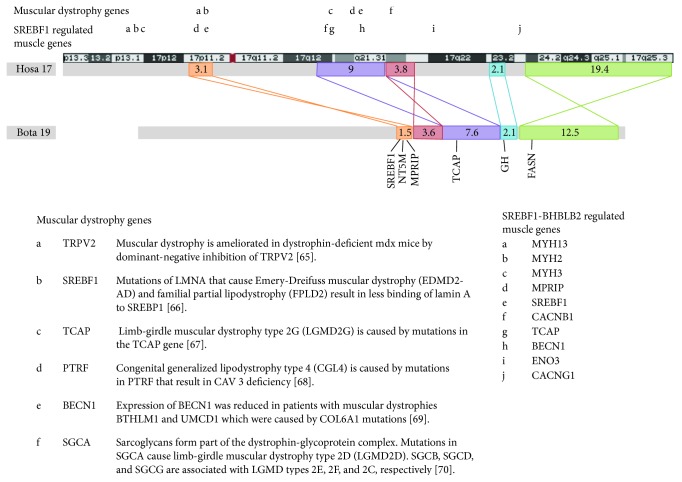
Marbling and muscular dystrophy are syntenic on Bota 19 and chromosome 17. Coloured boxes represent segments with the same gene content. Crossed joining lines indicate inverted translocations. Numbers represent Mb. Synteny was determined by the positions of homologous genes in the human assembly Hg 38 and bovine assembly BosTau8 located using the UCSC Genome Browser. Inverted sections and the exact location of boundaries between blocks were determined by dotplots [63] comparing the two sequences. The annotated dotplots used are shown in Supplementary Figure 1 available online at https://doi.org/10.1155/2017/6532837. The positions of genes associated with muscular dystrophy are shown in the first row of letters above Hosa 17. The association to muscular dystrophy is shown in the table below [65–70]. The positions of genes involved in the regulation of muscle development by SREBF1, either directly or through BHLHE40 and BHLHE41 (previously known as BHLHB2 and BHLHB3, resp.), are shown in the second row of letters above Hosa 17. Adapted from [3] with permission. We thank Dr. Joe Williamson for the assistance with this figure.